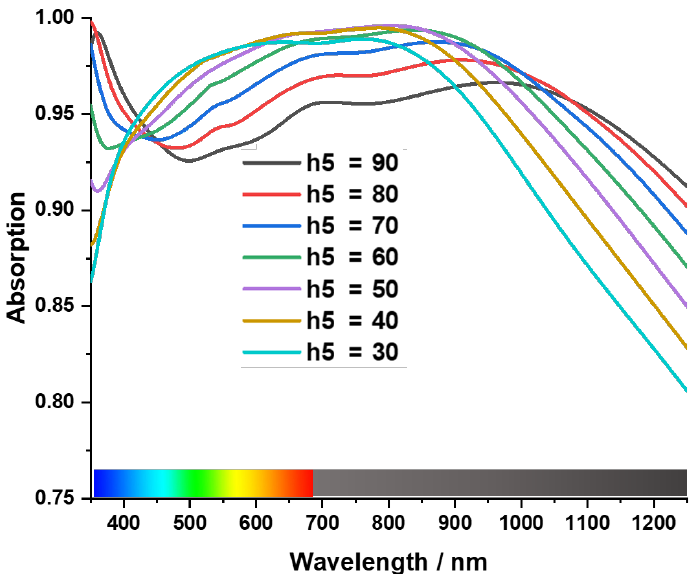
Figure 13. Comparison of SiO 2 at different thickness.